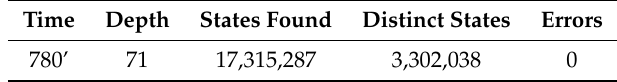
Table 2. Model checking results with three distributors and three iot devices with four pieces of patch